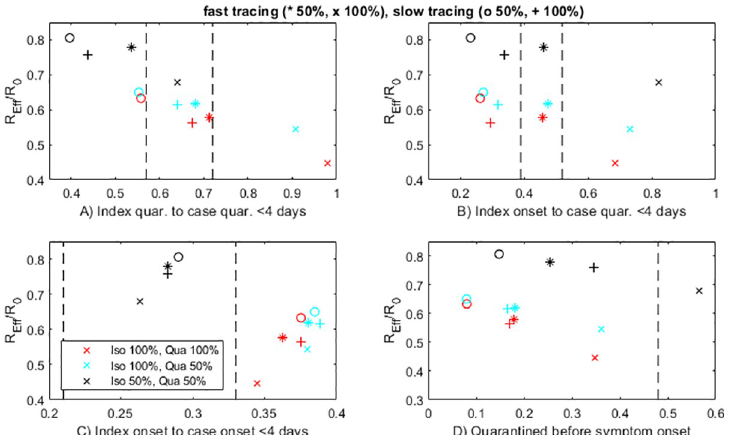
Fig 3. The proportion of cases quarantined or isolated within 4 days of the index case being quarantined or isolated (A) is the most robust indicator of the performance of the contact tracing system, measured by the reduction in effective reproduction number R eff relative to the no control case. Other indicators (B)-(D) are not reliably correlated across all model parameters. Each plotted point corresponds to one combination of model parameters: fast tracing (same time as test result) of 50% of contacts (stars); fast tracing of 100% of contacts (crosses); slow tracing (mean 3 days after test result) of 50% of contacts (circles); slow tracing of 100% of contacts (pluses); varying effectiveness of isolation and quarantine are shown by different colours (see graph legend). Other parameter values shown in Table 1. The horizontal axes show the proportion of cases meeting the specified performance indicator. Vertical dashed lines show the minimum and maximum values of the indicators computed from New Zealand case data. Indicator (D) can be calculated for all N = 93 cases in the dataset. Indicators (A)-(C) require an index case to be identified, which means they can only be calculated for 81 cases. 37 of these 81 cases have multiple potential index cases. The left-hand dashed line in (A)-(C) shows the result of selecting the index case corresponding to the smallest value of the indicator; the right-hand dashed line in (A)-(C) shows the result of selecting the index case corresponding to the largest value of the